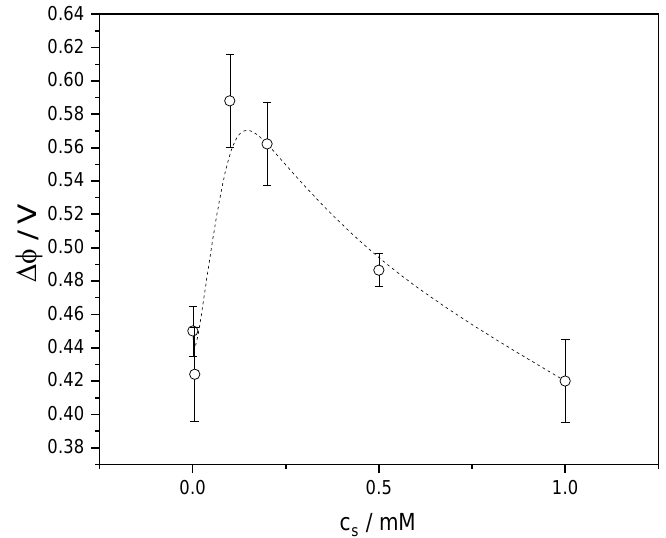
Figure 8. Change in the surface potential between water and surfactant solutions, ∆ ϕ = ϕ − ϕ water , as a function of surfactant concentration. This curve includes the values for c s = 0.01 and 0.06 mM which are not included in Figure 7.